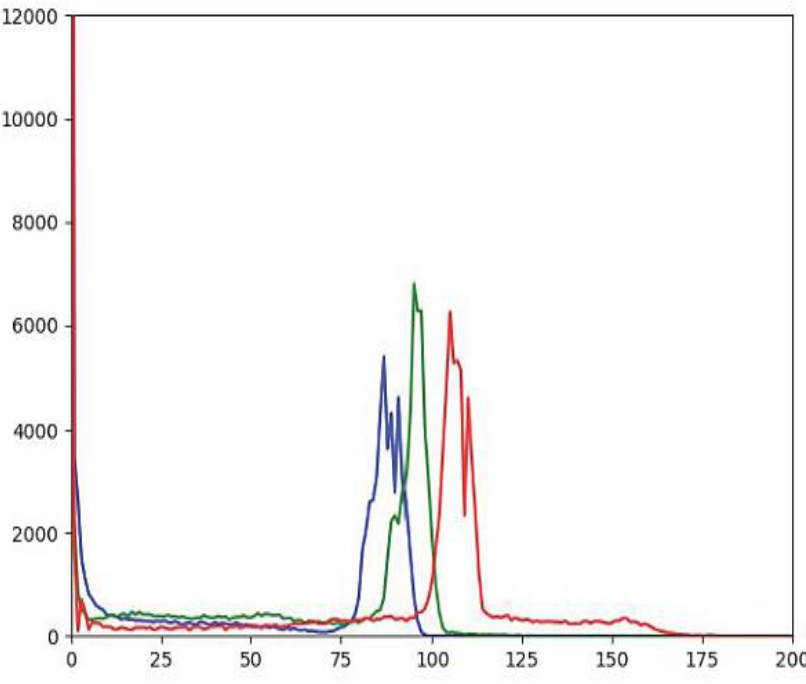
Figure 22. Histogram of the RGB graph for the image (see Figure